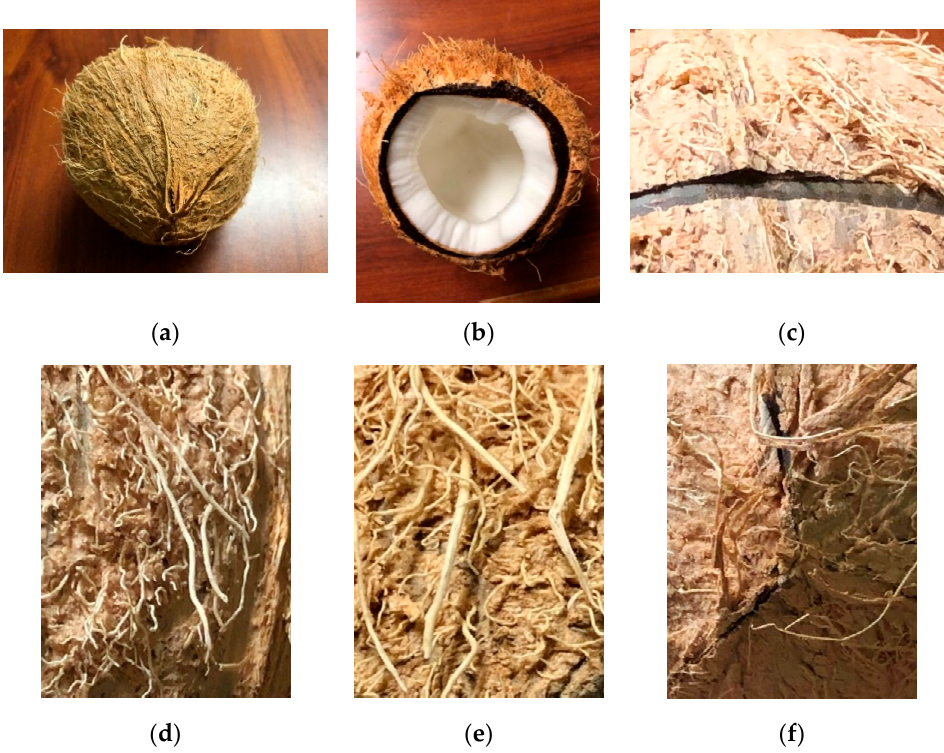
Figure 2. Outer-layer fibers of an adult coconut. ( a ) A complete coconut; ( b ) An opened coconut; ( c ) A surface cut; ( d ) Outer-layer fibers; ( e ) An enlarged view of the fibers; ( f ) One tip of the coconut.